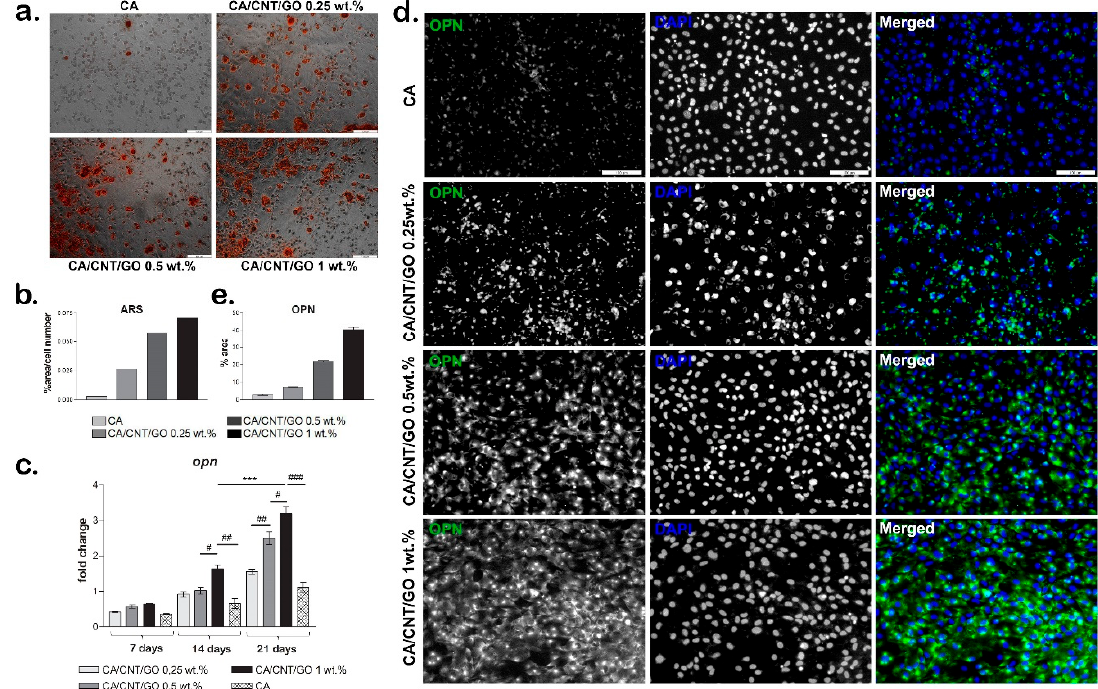
Figure 5. Evaluation of hASC osteogenic differentiation on CA-CNT-GO materials: ( a ) Alizarin Red S staining for measuring the level of mineralization, scale bar 100 µm. ( b ) quantification of the Alizarin Red S staining normalized to cell number, ( c ) osteopontin expression, Statistical significance: # p < 0.05; ## p < 0.01; ***/### p < 0.001, ( d ) immunofluorescence for osteogenic marker osteopontin ( OPN ), scale bar 100 µm and ( e ) quantification of the immunofluorescence staining of OPN .